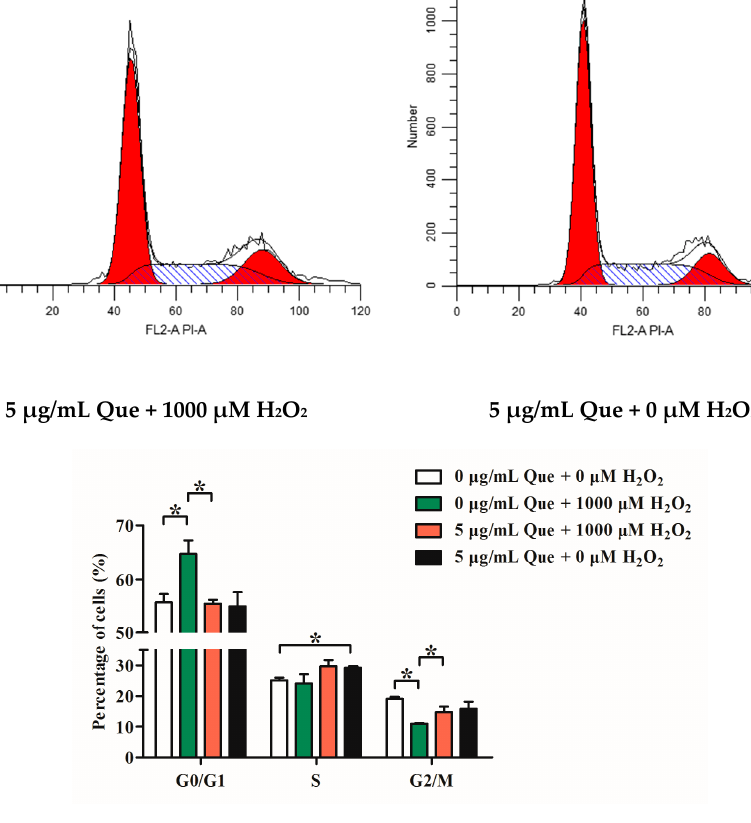
Figure 5. Effects of Que on apoptosis and cell cycle of IPEC-J2 exposure to H 2 O 2 . IPEC-J2 were pre-treated with Que for 3 h then treated with 1000 µ M H 2 O 2 for 4 h. ( a ) Flow detection diagram of apoptosis of IPEC-J2; ( b ) Histogram of apoptosis of IPEC-J2. ( c ) Flow detection diagram of cell cycle of IPEC-J2; ( d ) Histogram of cell cycle of IPEC-J2. Data are presented as mean ± SD. * p < 0.05 means significant difference between two groups.